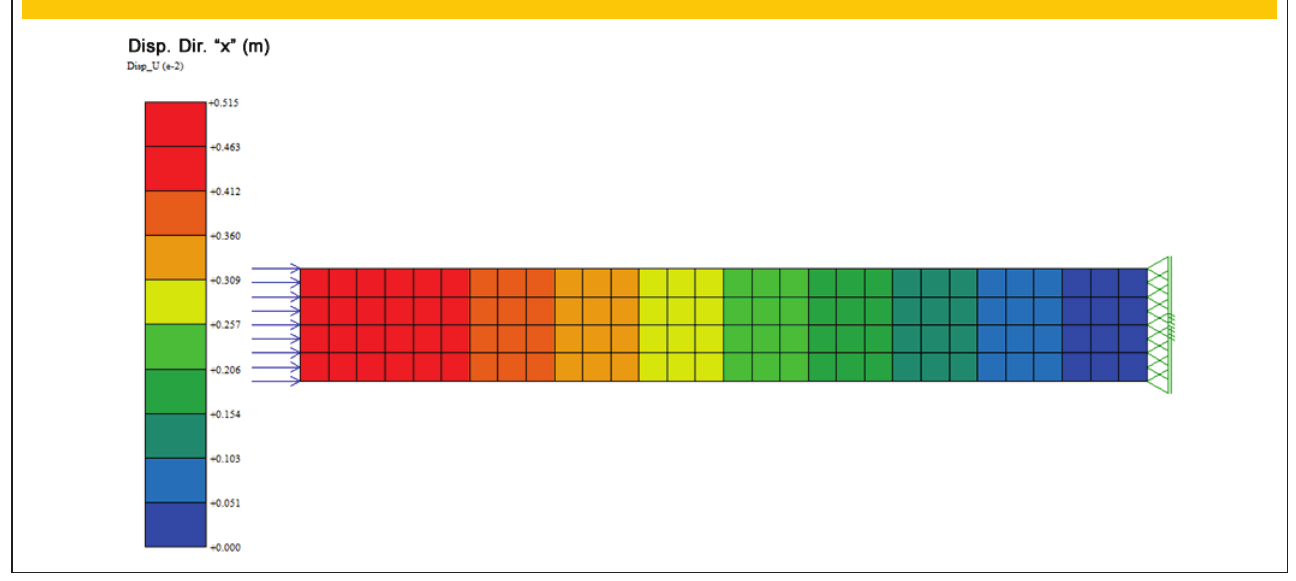
Figure 12 – Evolution of stresses in the concrete for 20 cm x 40 cm sections and 40% moisture content